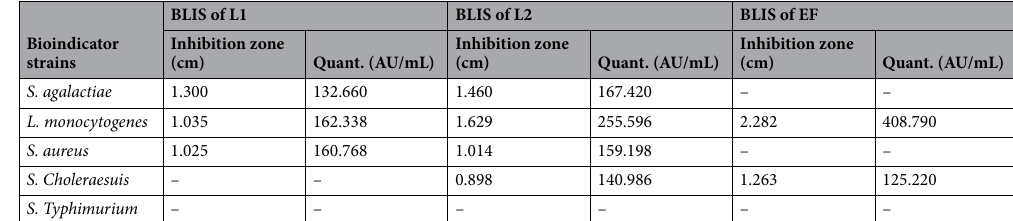
Table 3. Average diameter (cm) and quantification (AU/mL) of the BLIS inhibition halos against pathogens. “–” no inhibition.